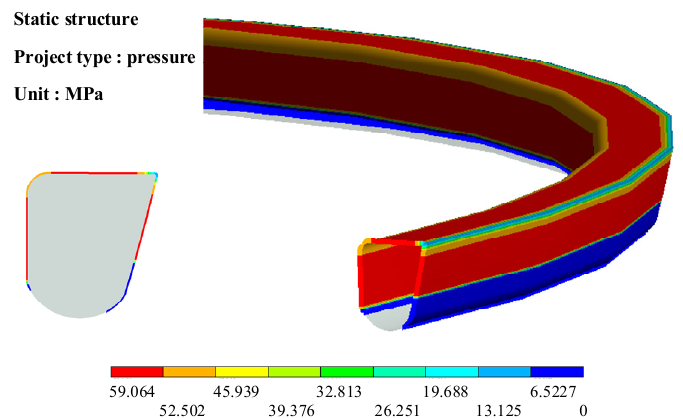
Figure 10. Nephogram of O-ring von Mises stress under working pressure.